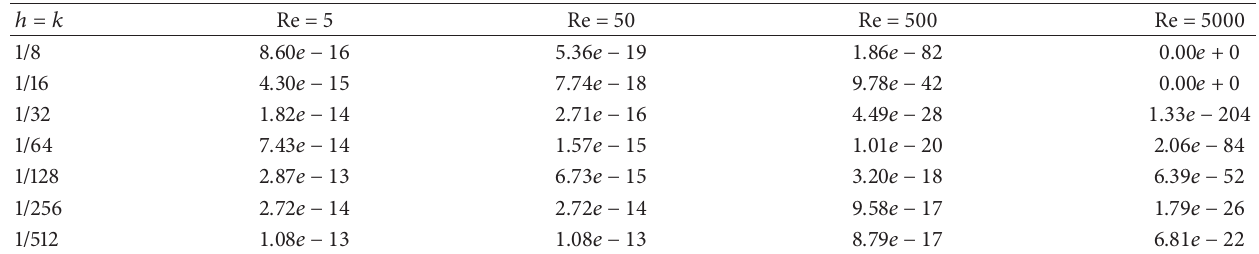
Table 2: Absolute errors for EDS solution of Example 7 with different values of